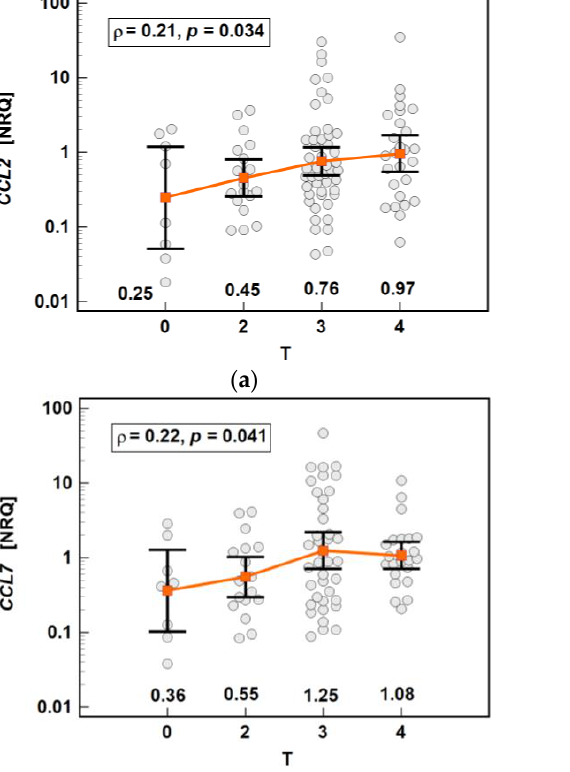
( d ) Figure 15. An expression of the MIP chemokines in tumor and tumor-adjacent tissue compared to normal mucosa from non-cancer patients: ( a ) CCL3 ; ( b ) CCL4 ; ( c ) CCL19; ( d ) CXCL2 . The data are presented as means ( CCL19 ) or medians ( CCL3 , CCL4 , and CXCL2 ) with 95% confidence intervals. The data were analyzed using one-way ANOVA with a Student-New- man-Keuls post hoc test or a Kruskal – Wallis H test with a Conover post hoc test, respectively. The significant between-